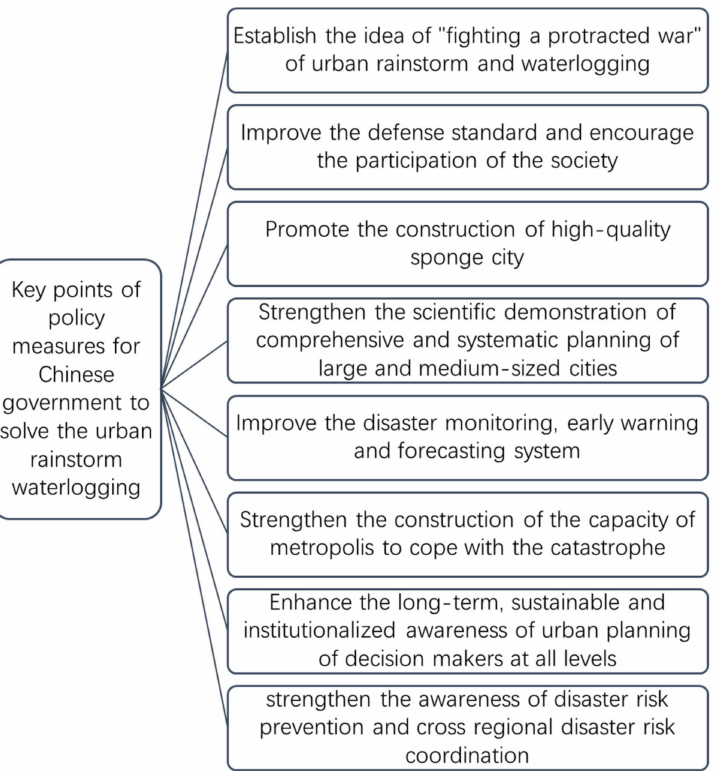
Figure 5. Key points of policy measures for the Chinese government to solve urban rainstorm